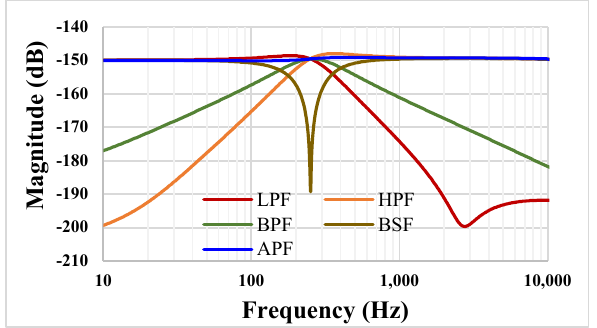
nS, and the −3 dB for the LPF was 323.3 Hz.